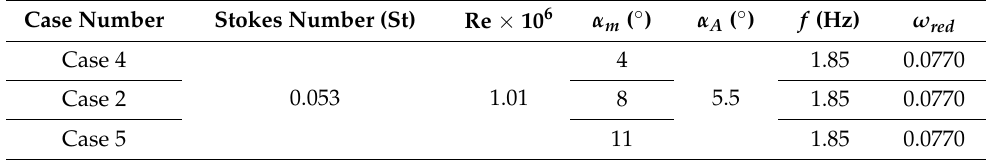
Table 3. The pitching parameters of three